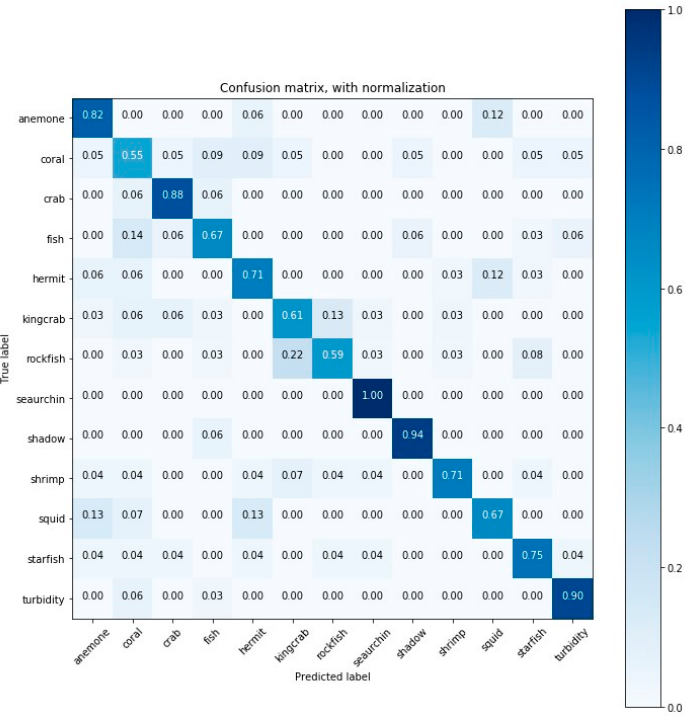
Figure A9. Confusion matrix for the classification results (accuracy) obtained by CNN-2.